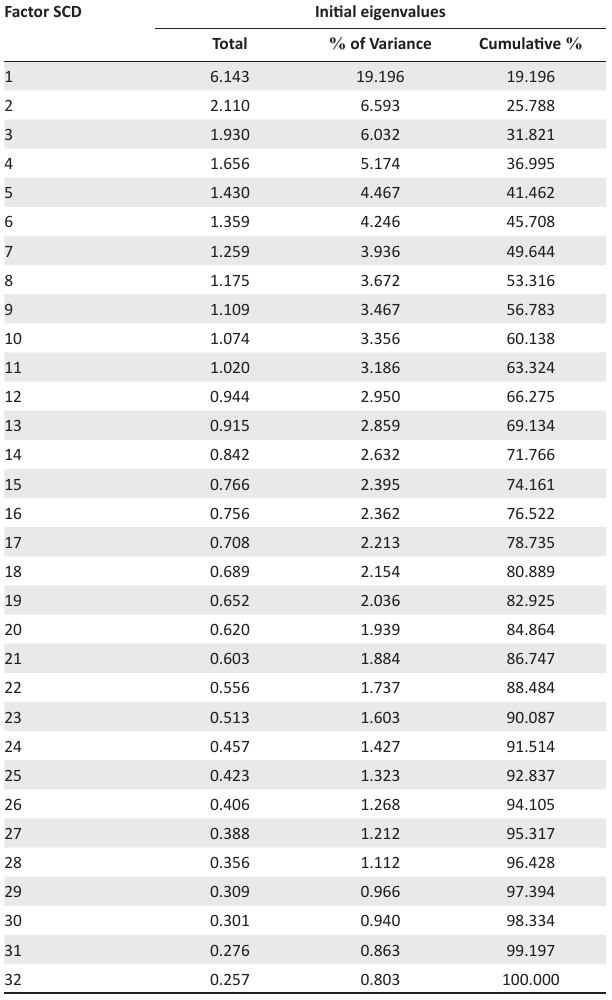
TABLE 2: Initial eigenvalues for structural capital disclosure (first-level factor analysis). Factor SCD